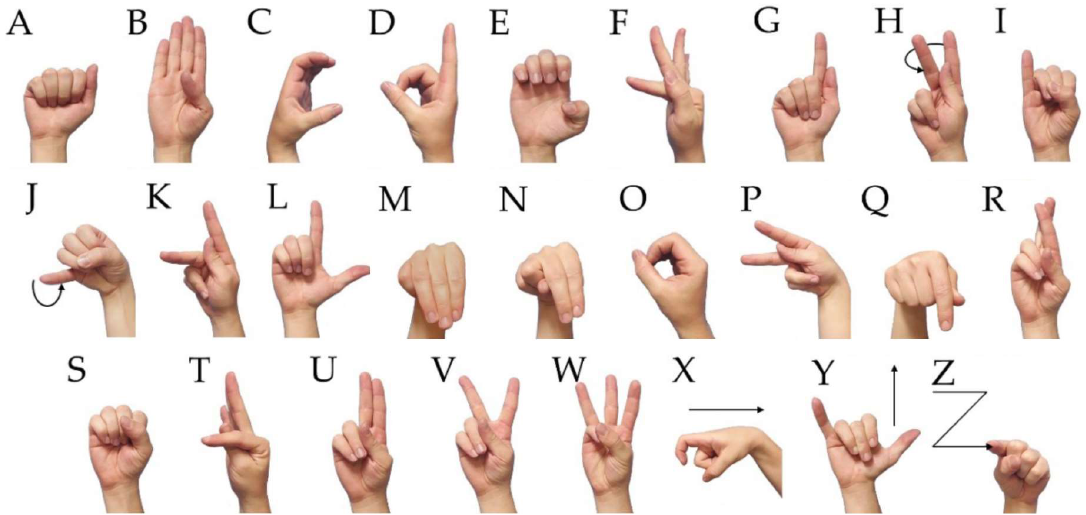
Figure 1. Alphabet set from Brazilian Sign Language (Libras). The set is composed of 26 letters, including 20 static gestures and six dynamic gestures.